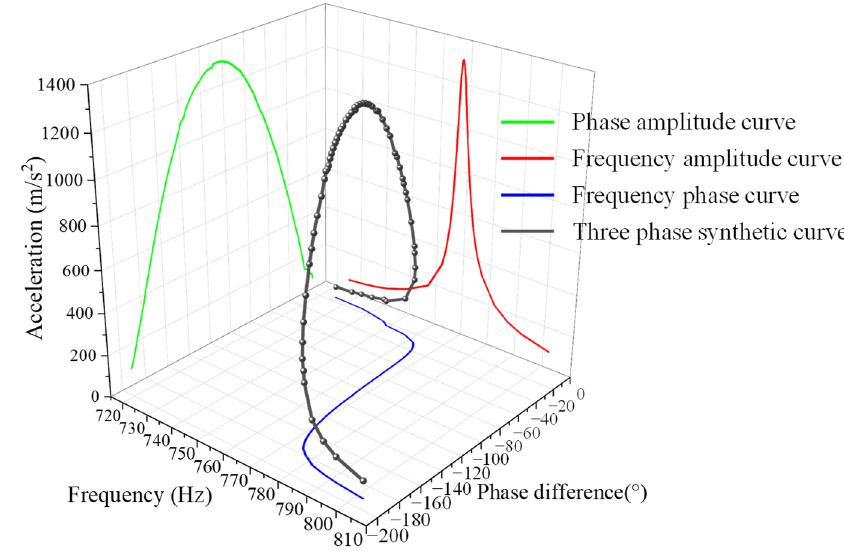
Figure 8. Phase–frequency change process.